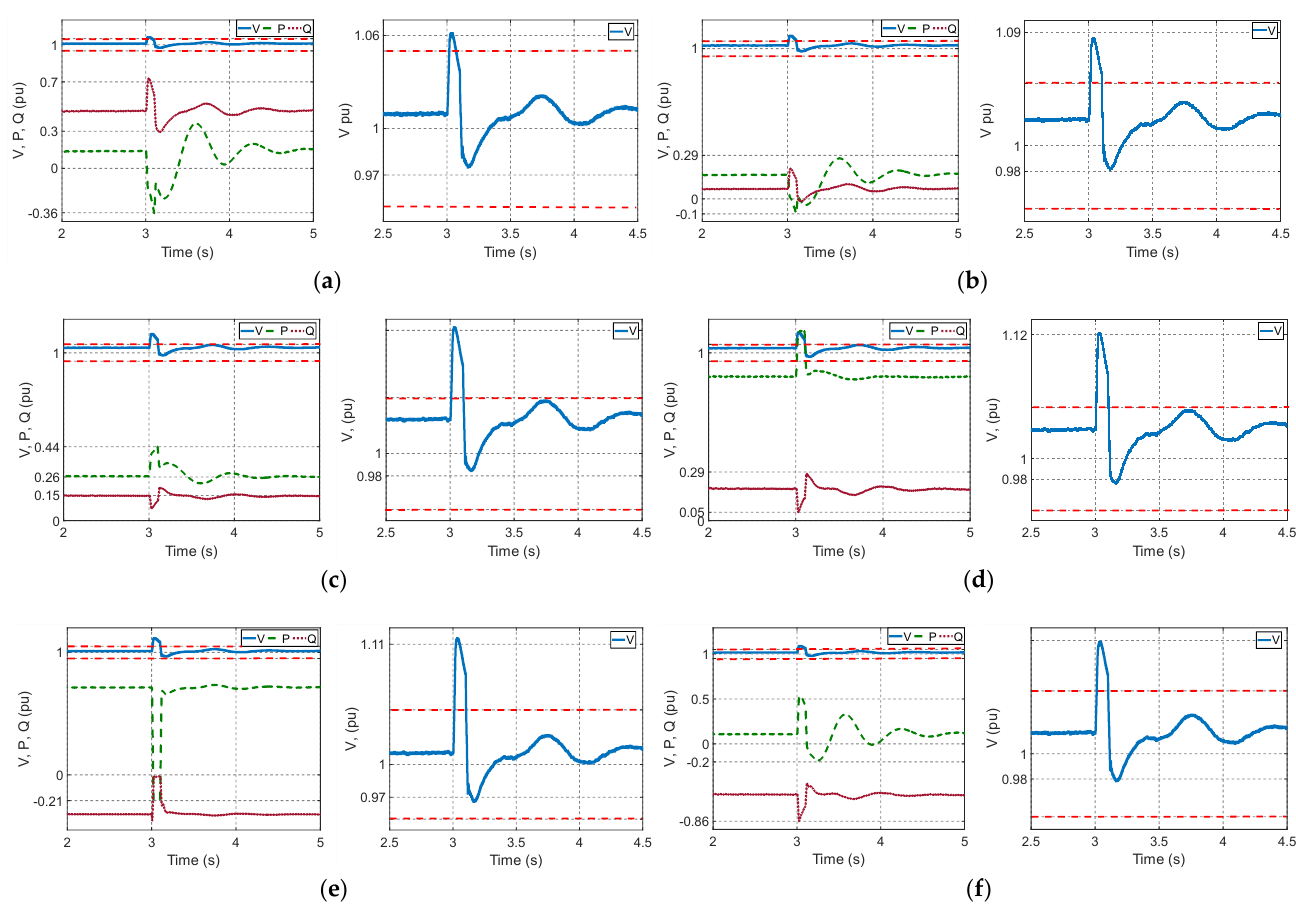
Figure 14. Scenario 2, results for the system buses: voltage (V), active power (P), reactive power (Q), and voltage zoom. ( a ) Bus 1; ( b ) bus 2; ( c ) bus 3; ( d ) bus 4; ( e ) bus 5; ( f ) bus 6.